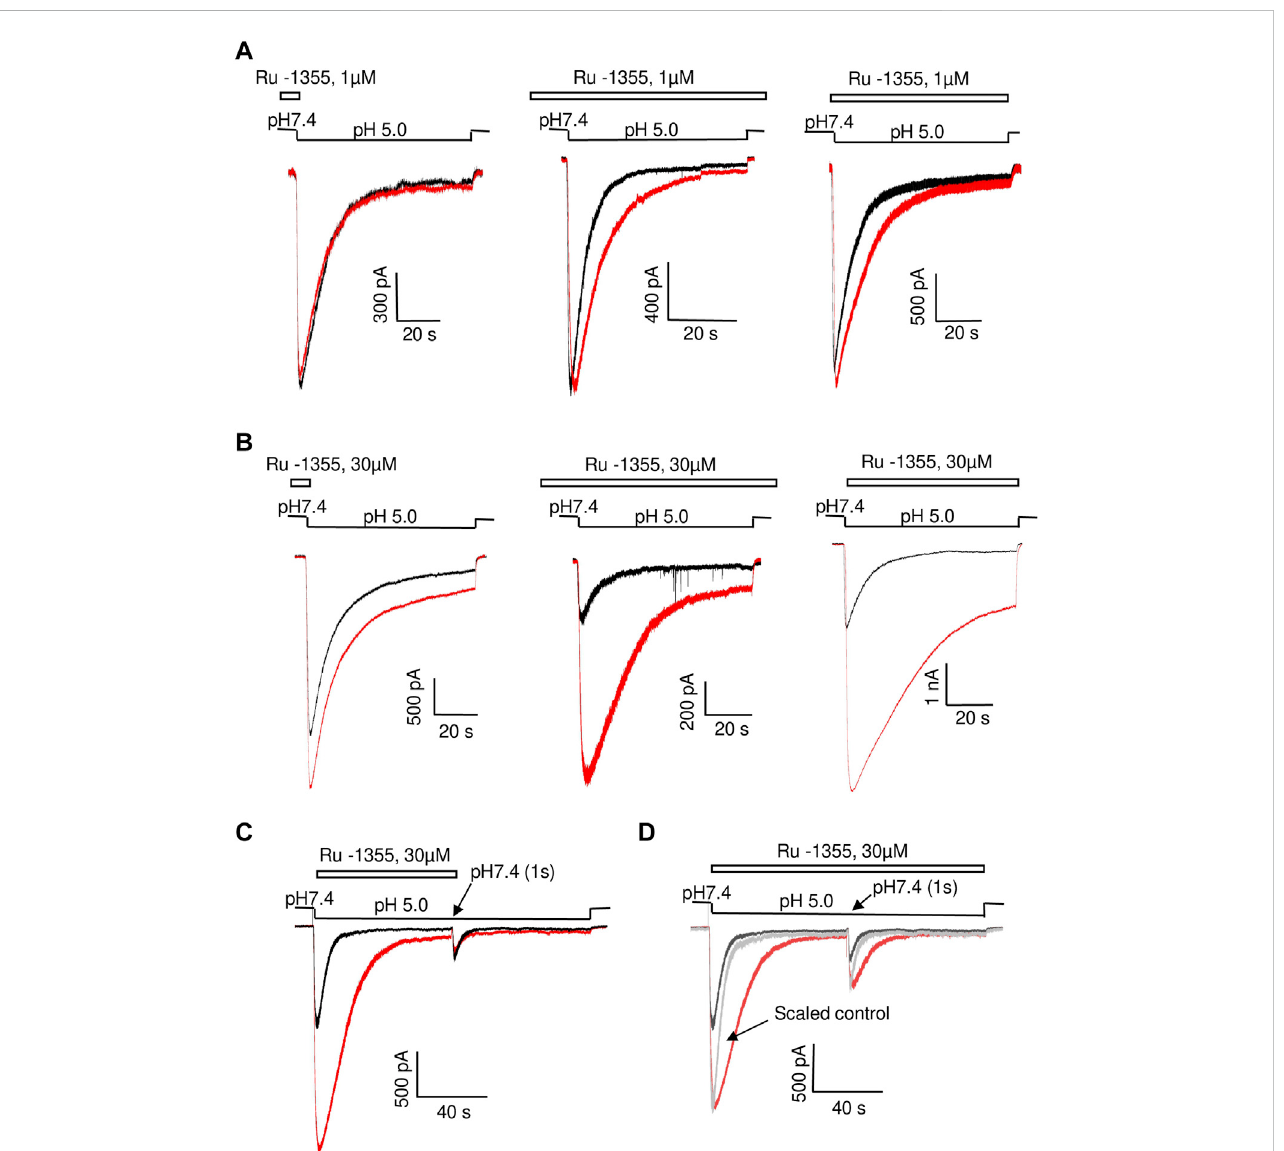
FIGURE 3 Comparison of Ru-1355 action on ASIC2a in different application protocols. Responses in the control condition are shown in black; responses in the presence of the drug are shown in red. Left panels show representative recordings in the experiments with Ru-1355 application only before activation. In the experiments shown in middle panels the compound was applied continuously. Right panels show the compound application simultaneously with the activating pH drops. (A, B) , action of 1 and 30 μ M, correspondingly. The results are summarized in Table 2. (C) , fast recovery of Ru-1355 effect. In the paired-activation protocol (1 s interval) the amplitude of second ASIC2a response is smaller than the amplitude of the fi rst response due to incomplete recoveryfromdesensitization.Ifthe fi rstresponseismodi fi edby30 μ MRu-1355,thesecondresponsedoesnotdifferfromthecontrolone. (D) ,Ru-1355does onaffecttherecoveryfromdesensitization.InthecontinuouspresenceofRu-1355(30 μ M)amplitudesofthe fi rstandsecondresponseareequallyincreased. Scaled control response (gray) matches both amplitudes but the responses in the presence of Ru-1355 are much